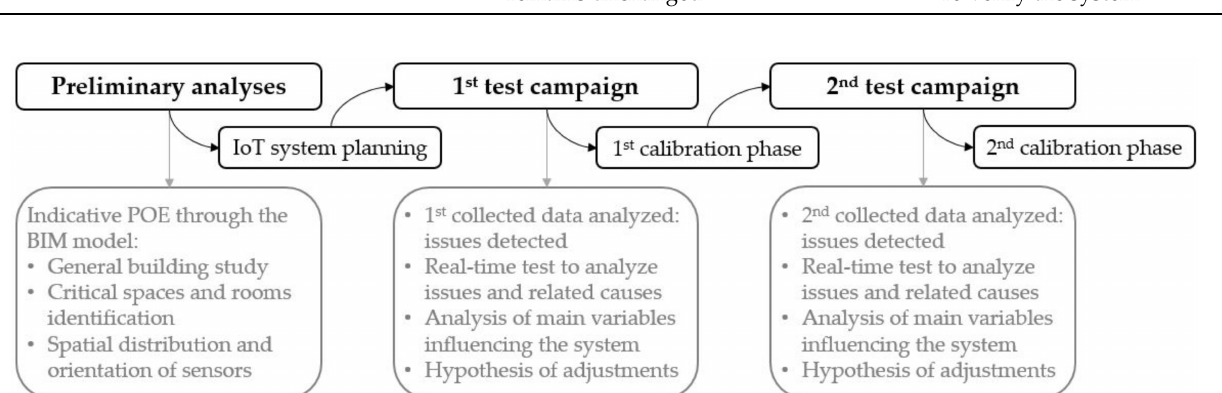
Figure 9. Preliminary analyses and two test campaigns